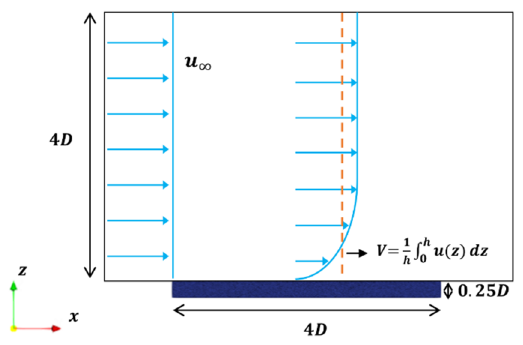
Figure 6. Computational domain for incipient motion.